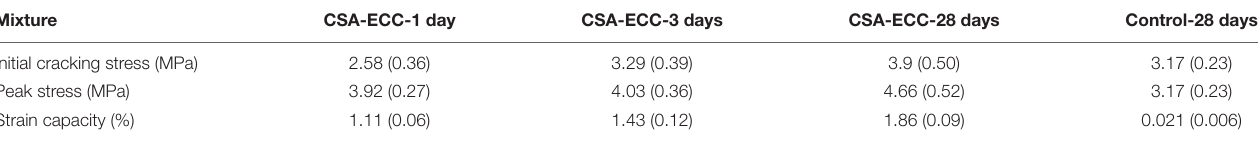
TABLE 6 | Tensile test results of the CSA-ECC*.